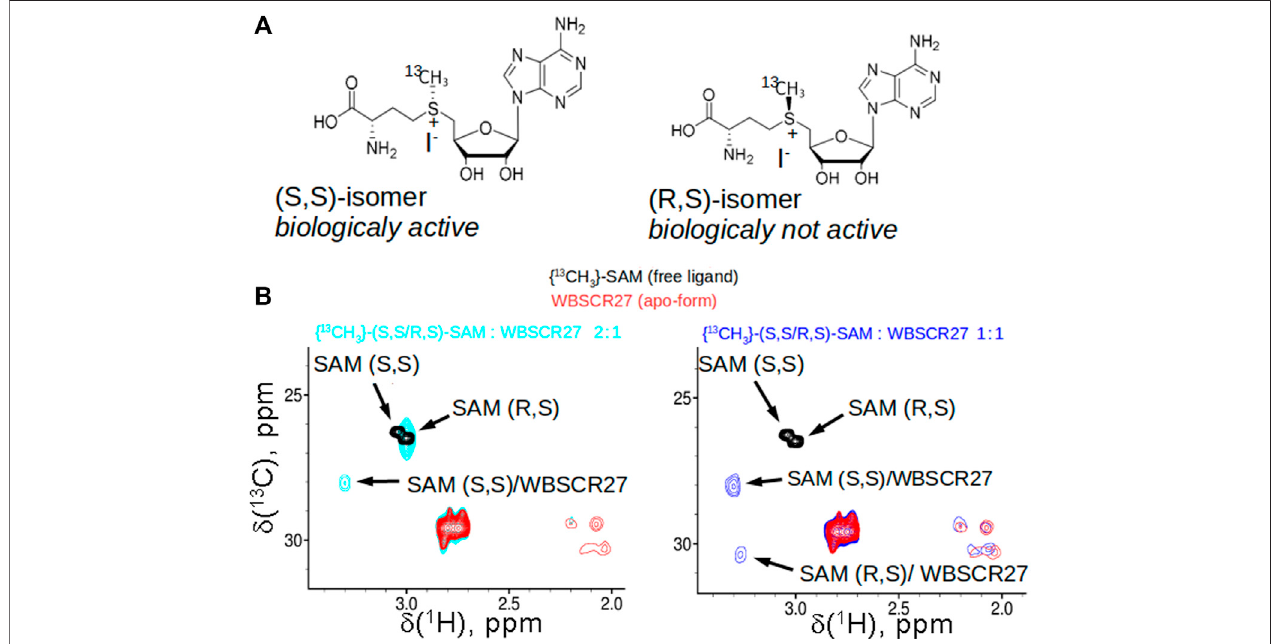
FIGURE2| SAMstereoisomersandtheirbindingtoWBSCR27. (A) TwostableepimersofSAM:biologicallyactive(S,S)-SAM,synthesizedenzymaticallyfromATP andmethionineincells,and(R,S)-SAM,whichisobtainedasaby-product synthetically. (B) Overlayofthefragmentsof 13 C, 1 HHSQCspectraofracemic 13 CH 3 -labelled (R,S/S,S)-SAM (black), apo-WBSCR27 (red) and the mixture of SAM and protein in the ratio 2:1 (cyan, shown in the left panel) or 0.9:1 (blue, shown in the right panel).